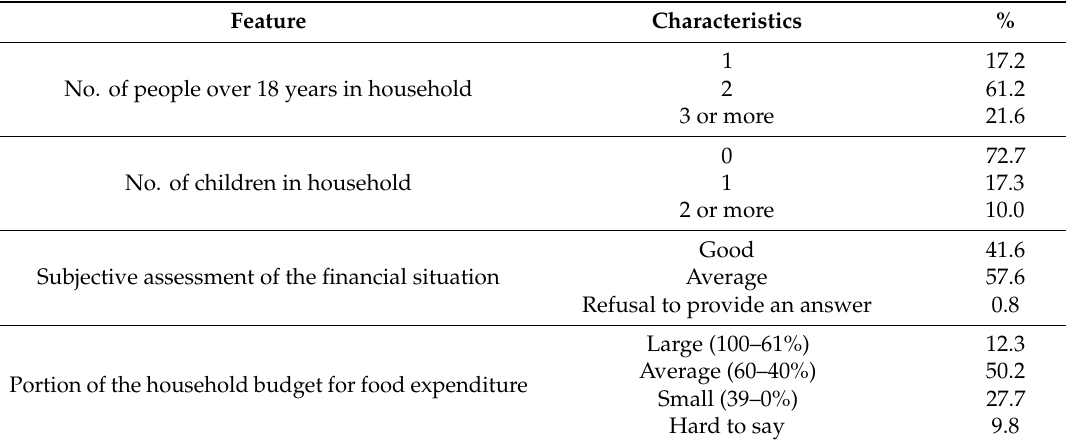
Table 1. Sociodemographic profile of consumer groups ( n =